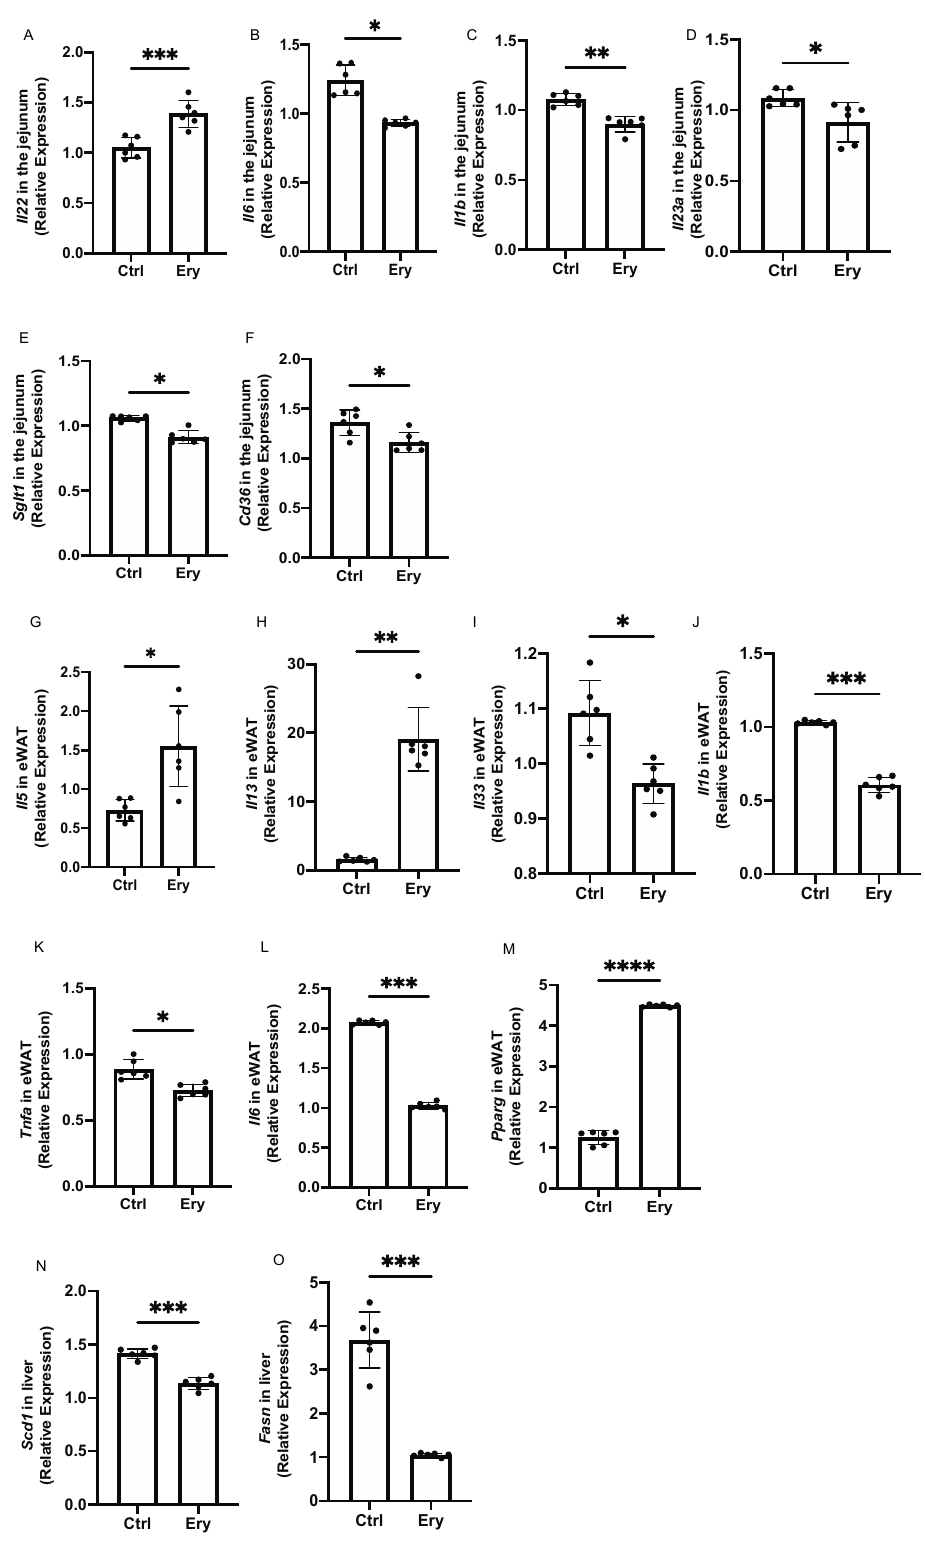
Figure 6. Erythritol decreased the expression of inflammation-related genes in the small intestine and white adipose tissue. ( A ) Il22 , ( B ) Il6 , ( C ) Il1b , ( D ) Il23a, ( E ) Sglt1 , and ( F ) Cd36 gene expression in the small intestine ( n = 6). ( G ) Il5 , ( H ) Il13 , ( I ) Il33 , ( J ) Il1b , ( K ) Tnfa , ( L ) Il6, and ( M ) Pparg gene expression in epididymal white adipose tissue (eWAT) ( n = 6). ( N ) Scd1 and ( O ) Fasn gene expression in liver (n = 6). Data have been represented in terms of mean ± SD values. * p < 0.05, ** p < 0.01, *** p < 0.001, and **** p < 0.0001 using an unpaired t